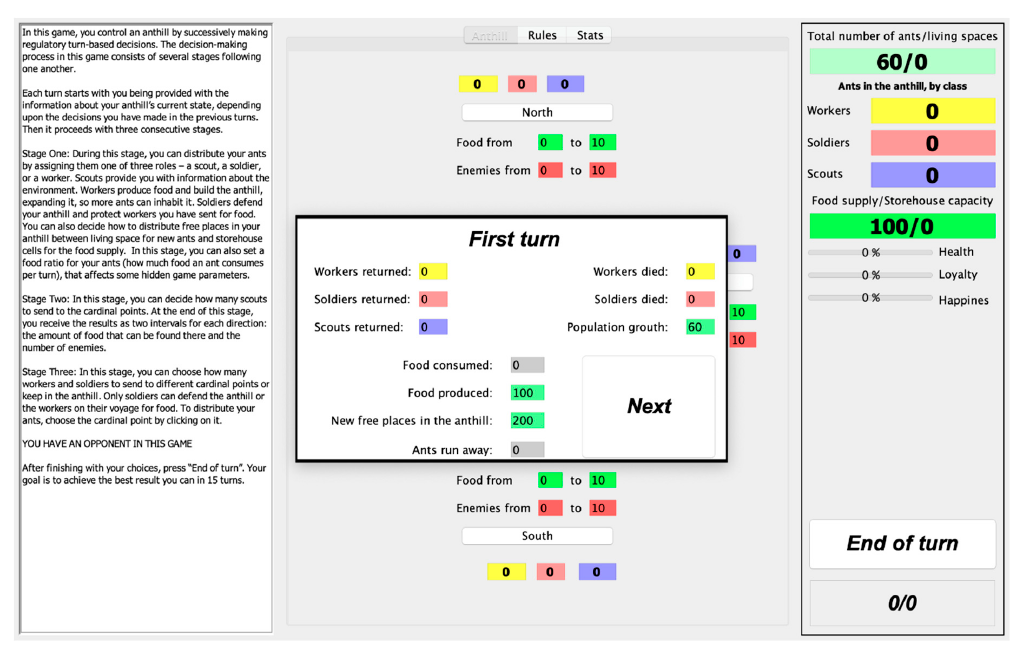
Figure A1. “The Anthill” starting window.